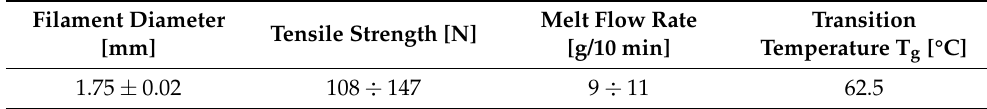
Table 2. Nominal PLA filament properties provided by the